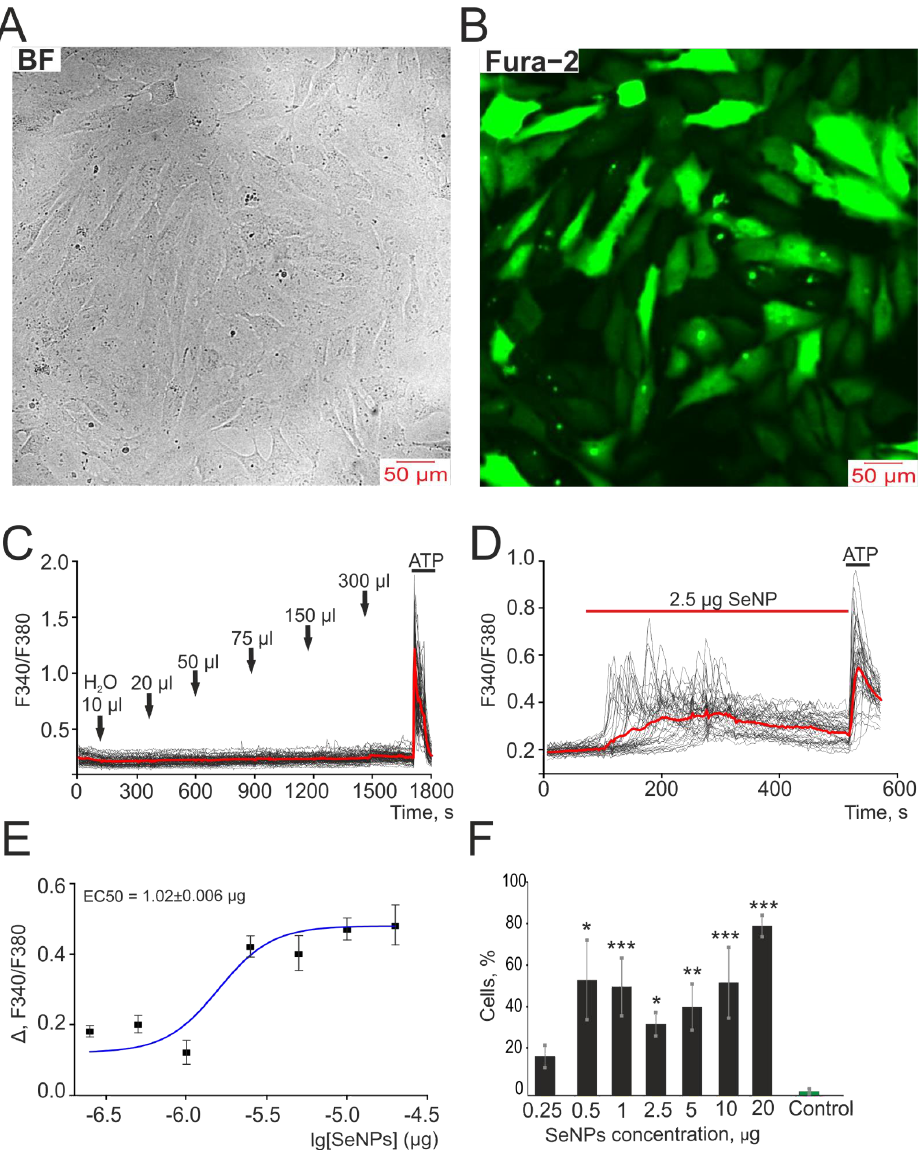
Figure 1. Application of SeNP dose-dependently induces the generation of Ca 2+ signals in human A-172 glioblastoma cells. At the end of the experiment, 10 µ M adenosine triphosphate (ATP) was added. ( A , B ) Images of A-172 cell culture in bright field microscopy ( A ) and Fura-2 fluorescence ( B ) at an excitation of 380 nm. ( C ) The absence of Ca 2+ signals when different volumes of distilled water are applied to the cells. ( D ) Generation of Ca 2+ signals in 36 ± 7% of cells in response to application of 2.5 µ g/mL SeNP. ( E ) Dependence of the amplitude of Ca 2+ responses of cells on the growth of SeNP concentration and its approximation by a sigmoid function. ( F ) Percentage of cells in culture that respond to the application of 300 µ L distillated water (control) and various concentrations of SeNP. Ca 2+ signals in cells and their average value (red curve) are shown. The differences between the 0.25 µ g/mL SeNP and other concentrations of SeNP are marked with asterisks—* p < 0.05, ** p < 0.01, and *** p < 0.001. n/s—differences